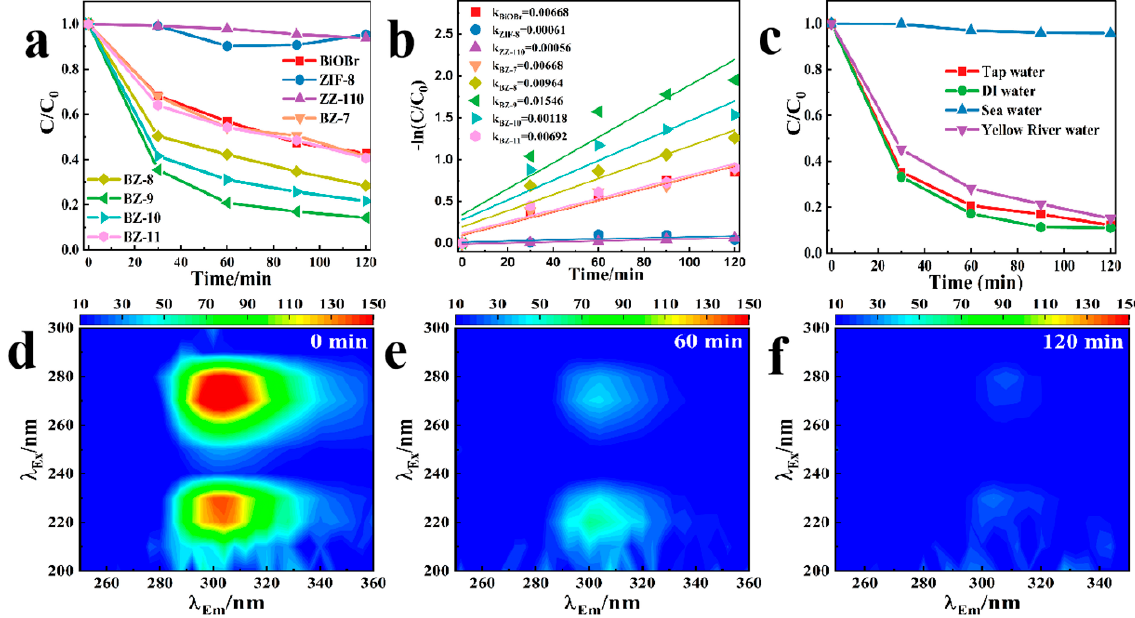
Figure 6. BPA degradation of the preparation materials ( a ), and the corresponding pseudo first or ‐ der dynamics curve ( b ); BPA degradation in natural water bodies using BZ − 9 ( c ); 3D EEMs of BPA ( d – f